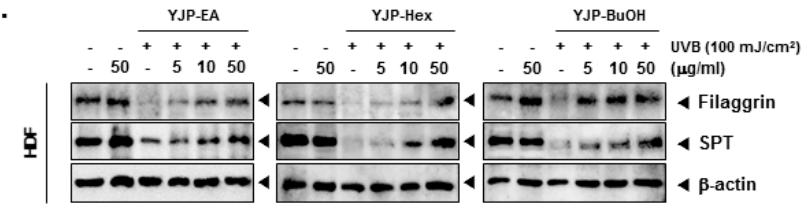
Figure 4. Melanin inhibition effects of YJP-EA, Hex, and BuOH on B16F10 cells. ( A ) B16F10 cells were treated with YJP-EA, Hex, and BuOH for 24 h. Next, the cell viability was measured using the MTT assay. ( B ) Melanin contents from α -MSH-stimulated B16F10 cell. The cells were treated with α -MSH (200 nM) and YJP-EA, Hex, and BuOH for 48 h. The cell lysates were measured at 490 nm. ( C ) To measure intracellular tyrosinase activity, the B16F10 cells were treated with -MSH (200 nM) and YJP-EA, Hex, and BuOH for 72 h. L-DOPA was added into the lysates and measured at 490 nm. ( D ) The mushroom tyrosinase activity was evaluated at -MSH (200 nM) and in YJP-EA-, Hex-, and BuOH-treated B16F10 cells. The supernatants with L-DOPA and tyrosinase were measured at 475